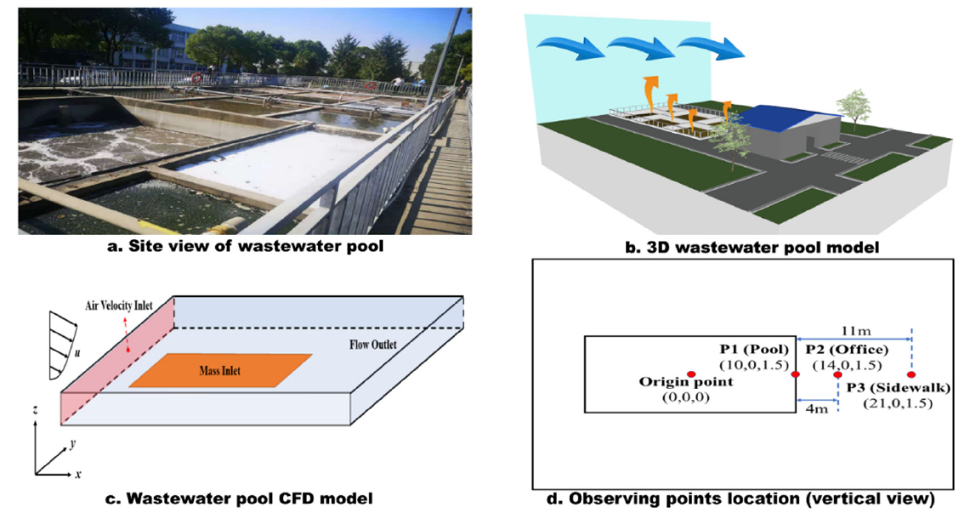
Figure 1. ( a ) The onsite view of the washing sewage sedimentation tank; ( b ) The 3D model of the onsite view; ( c ) The CFD model of the onsite view; ( d ) The schematic diagram of monitoring points. The numbers in parentheses represent x, y, z three-dimensional coordinates of monitoring points.